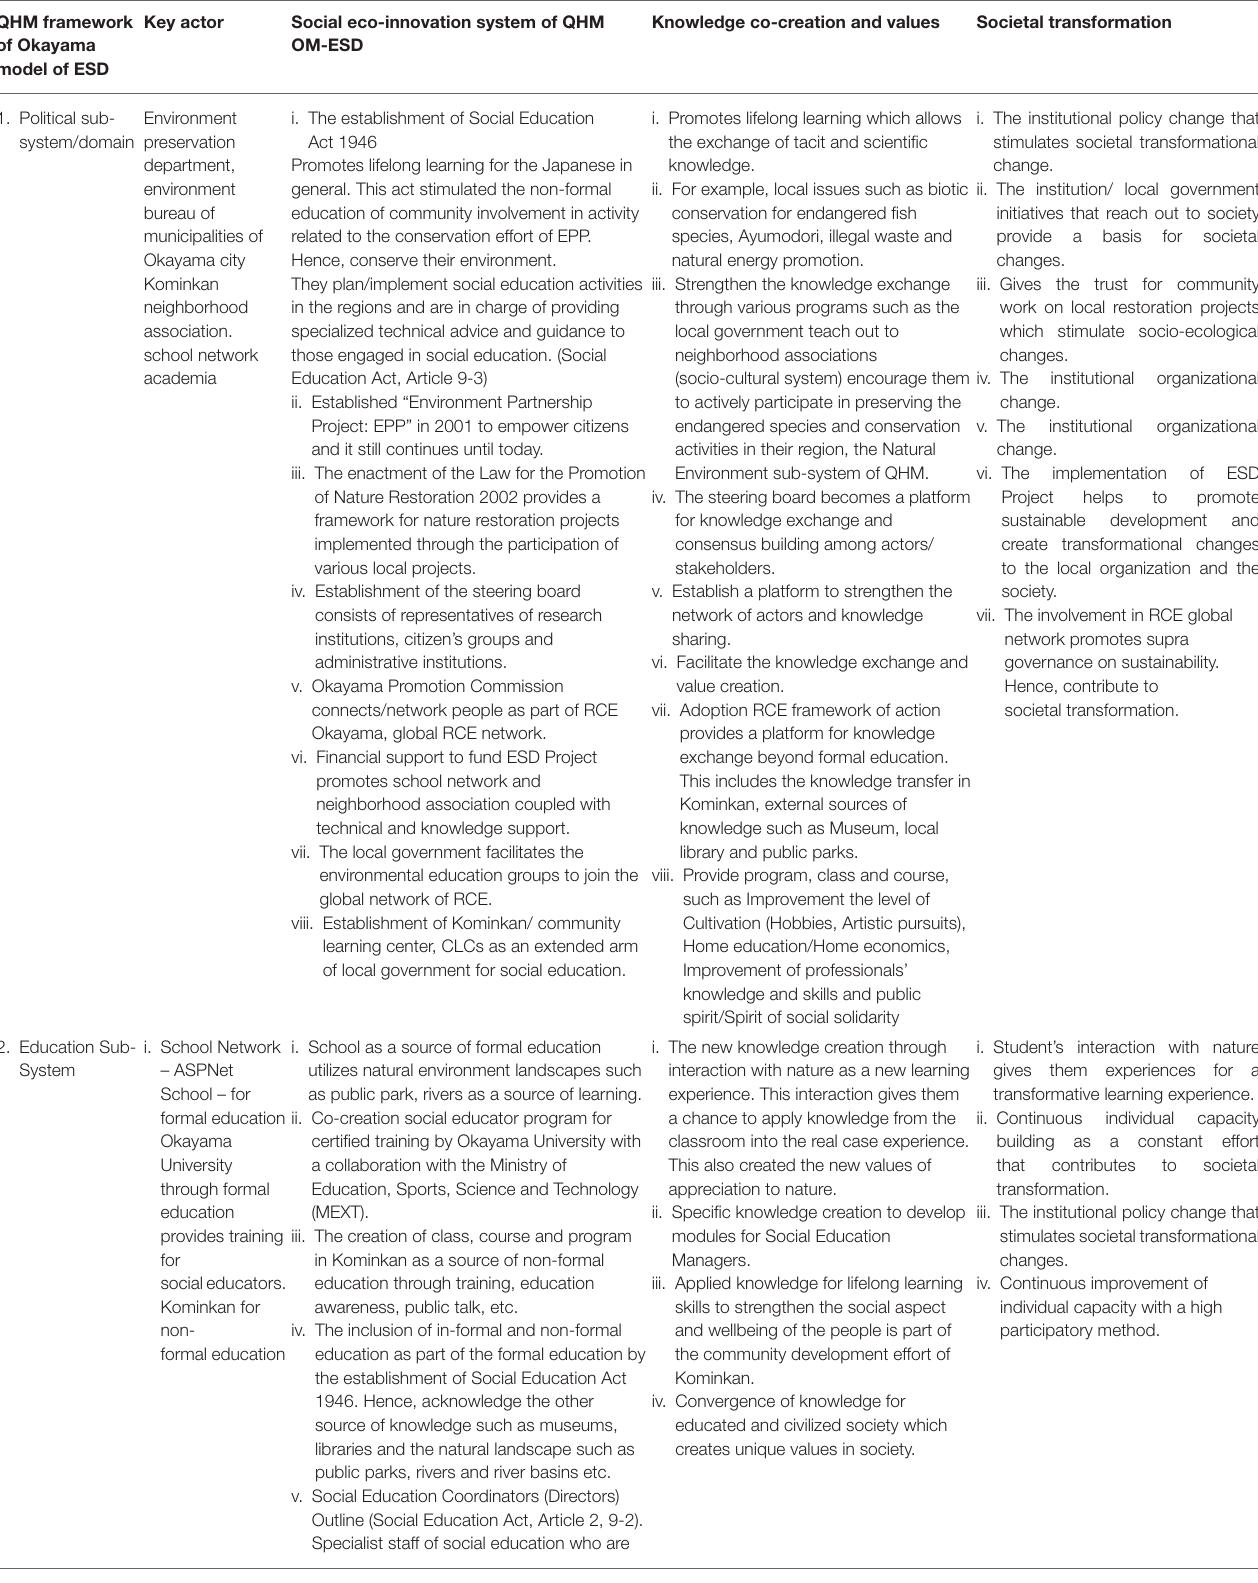
TABLE 3 | Quintuple helix model, QHM analysis of Okayama model of ESD for transformation. QHM framework of Okayama model of